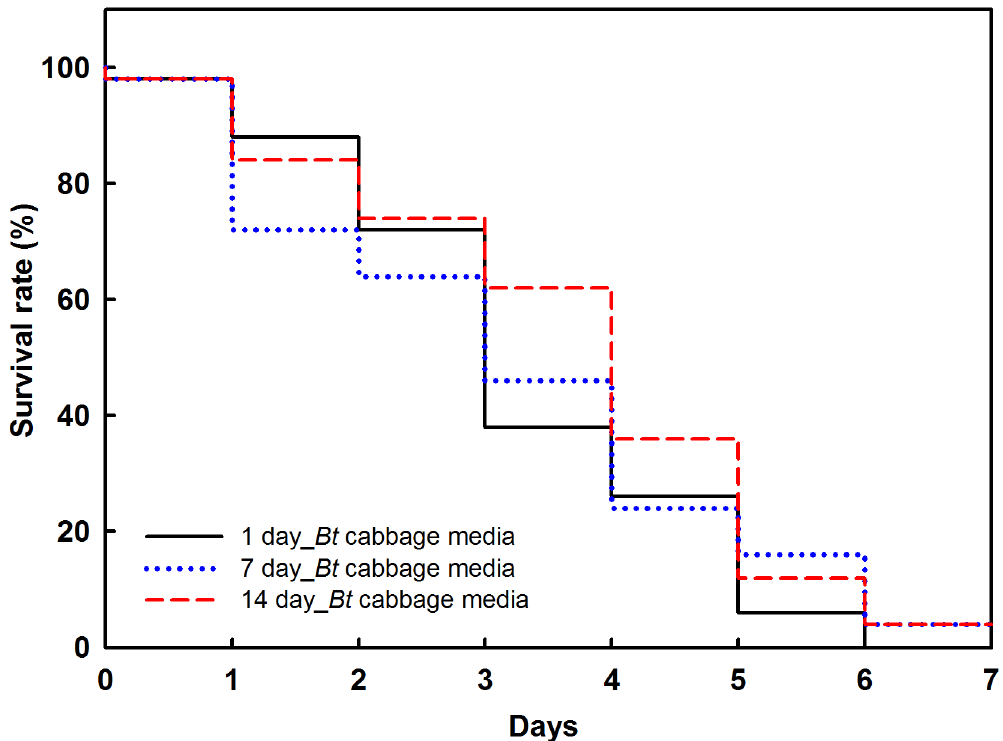
Fig 1. Overall survival of P . xylostella that had preyed upon drosophila media containing Bt cabbage powder. The drosophila medium was stored for 1 (black solid line), 7 (blue dotted line), or 14 (red dashed line) days at room temperature, and was used to verify its insecticidal activity. Data were derived from Kaplan-Meier curves ( n =